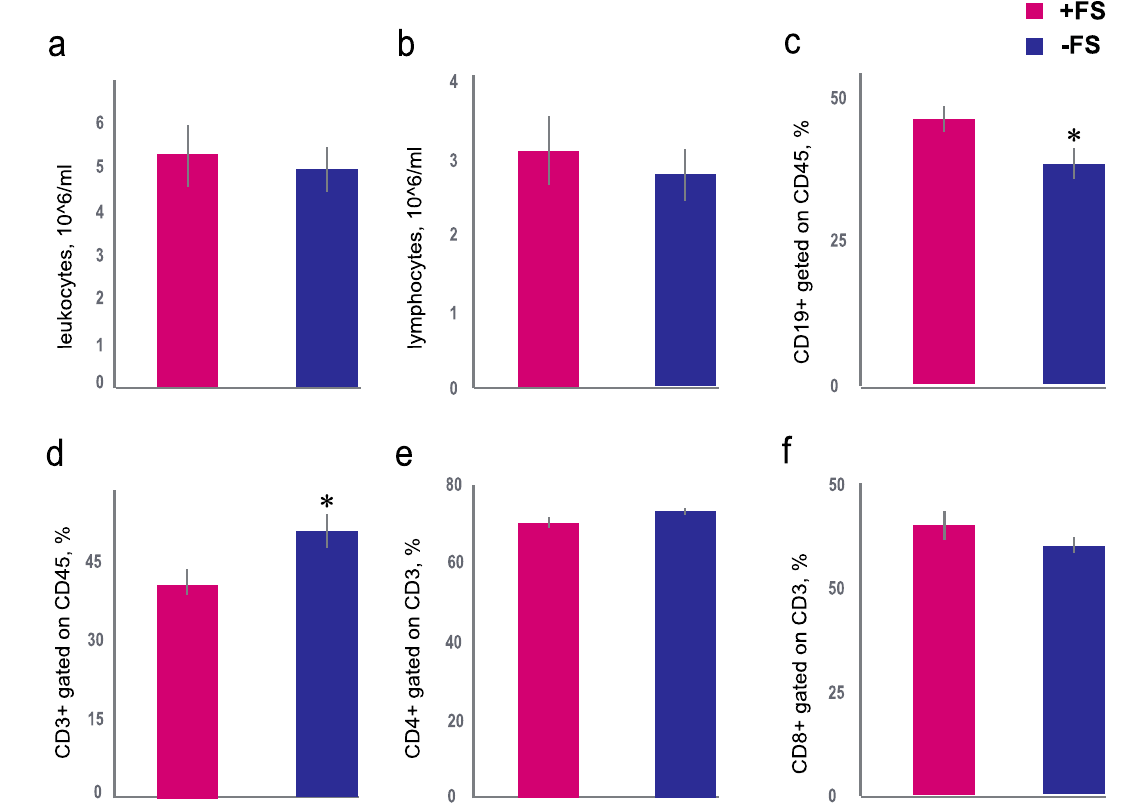
Figure 2. Effect of exposure to female scent on the blood leukocytes of male mice. ( a ) The number of leukocytes in the blood for +FS group (red column) and –FS group (blue column). ( b ) The number of lymphocytes in the blood for +FS group (red column) and –FS group (blue column). ( c ) The percentage of B cells (CD19) in the blood for +FS group (red column) and –FS group (blue column). ( d ) The percentage of T- cells (CD3) in the blood for +FS group (red column) and –FS group (blue column). ( e ) The percentage of T helper cells (CD4+) in the blood for +FS group (red column) and –FS group (blue column). ( f ) The percentage of T cytotoxic cells (CD8+) in the blood for +FS group (red column) and –FS group (blue column). *- p < 0.05 Mann–Whitney U-test. Data are presented as the mean ± standard error.